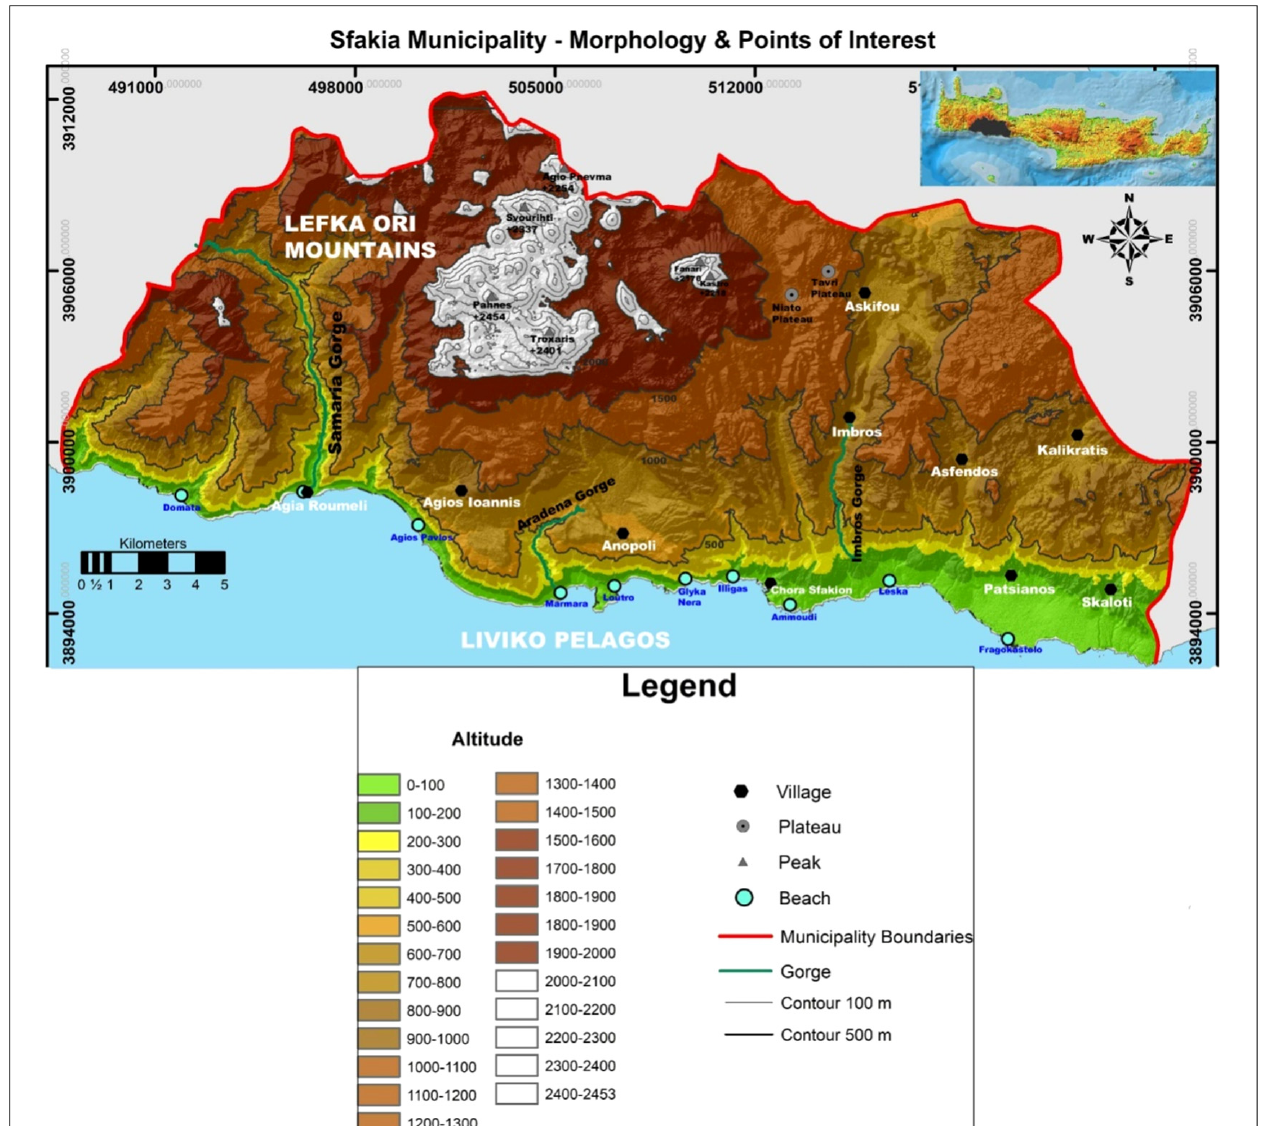
Figure 5. Sfakia Municipality morphological map. The map was formed in the context of this study. The altitude zones are represented in different colors, as symbolized in the legend. They range from 0 in the coastal zone to the highest altitude of +2,454 m in the highest peak “Pachnes” of the “Lefka Ori” Mountains. The main morphological features, such as major peaks, gorges, plateaus and seaside points of interest, are depicted as well.